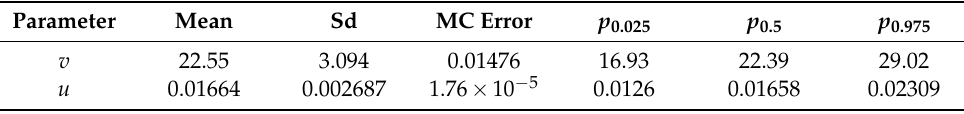
Table 2. Obtained estimations for the observed degradation.